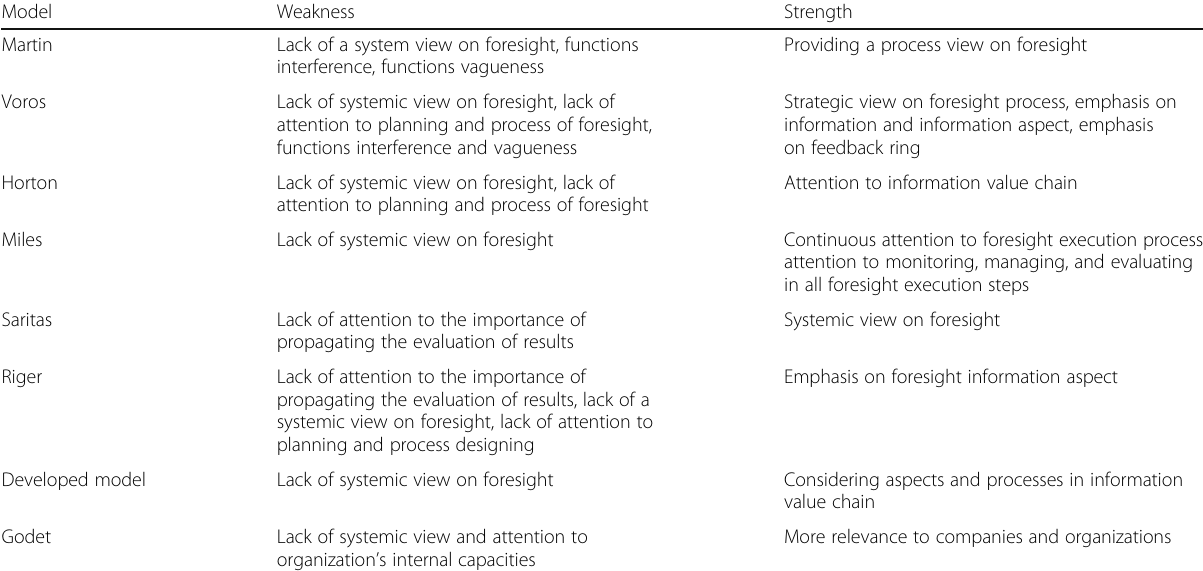
Table 2 Strength and weakness of foresight common models